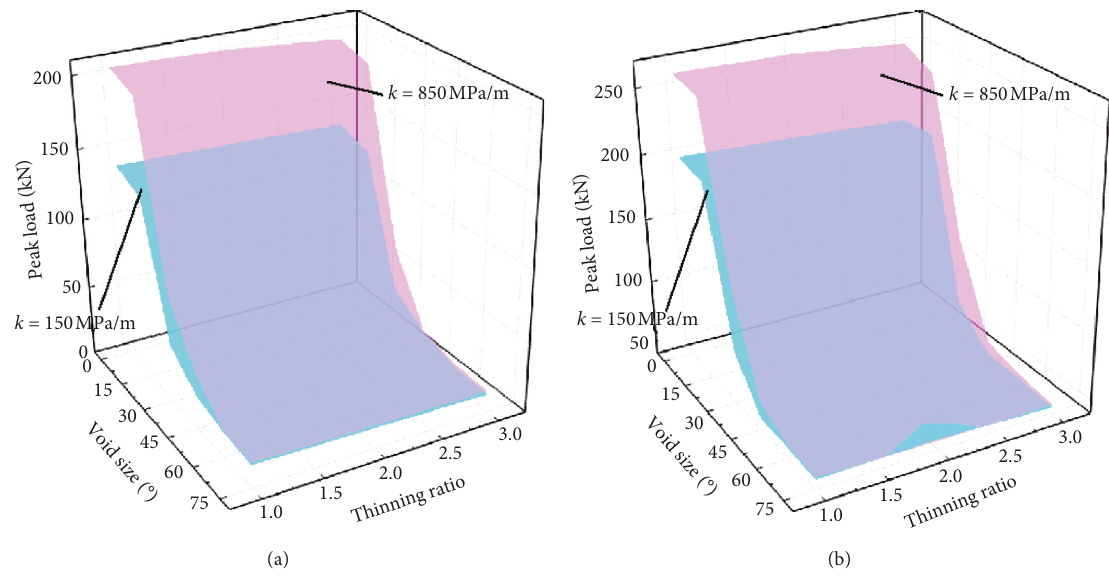
Figure 17: Three-dimensional curved surfaces of peak load and combined defects at vault spandrel. (a) Vertical load. (b) Horizontal load.